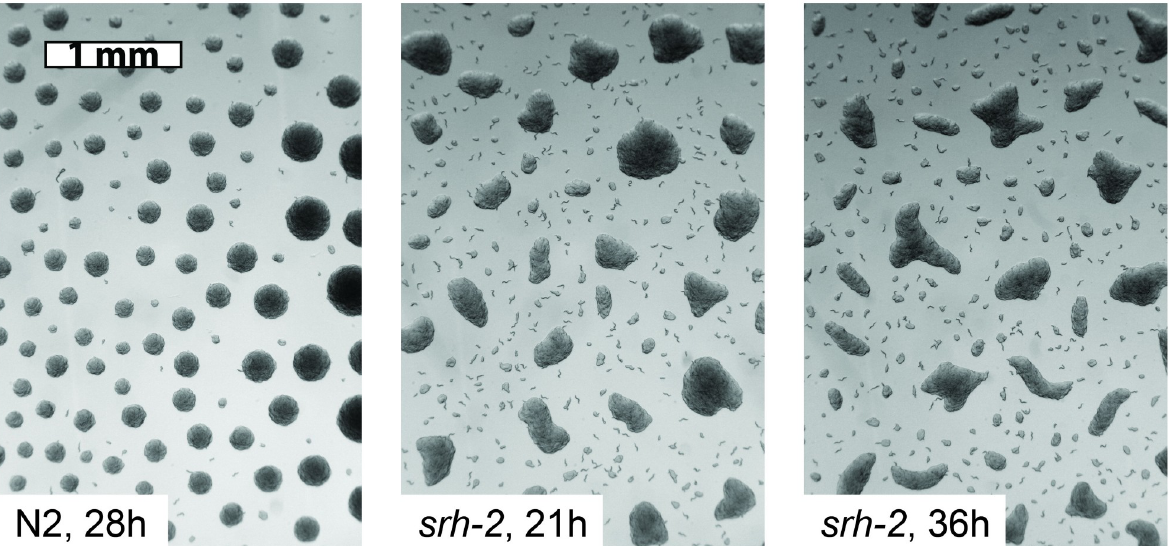
Fig 4. srh–2 knockout L1 aggregation. Starved L1s of mutant worms lacking a functional srh–2 gene aggregate, but the aggregates they form are irregularly shaped (the animal crackers phenotype). srh–2 encodes a G–protein coupled receptor expressed in starving L1s.